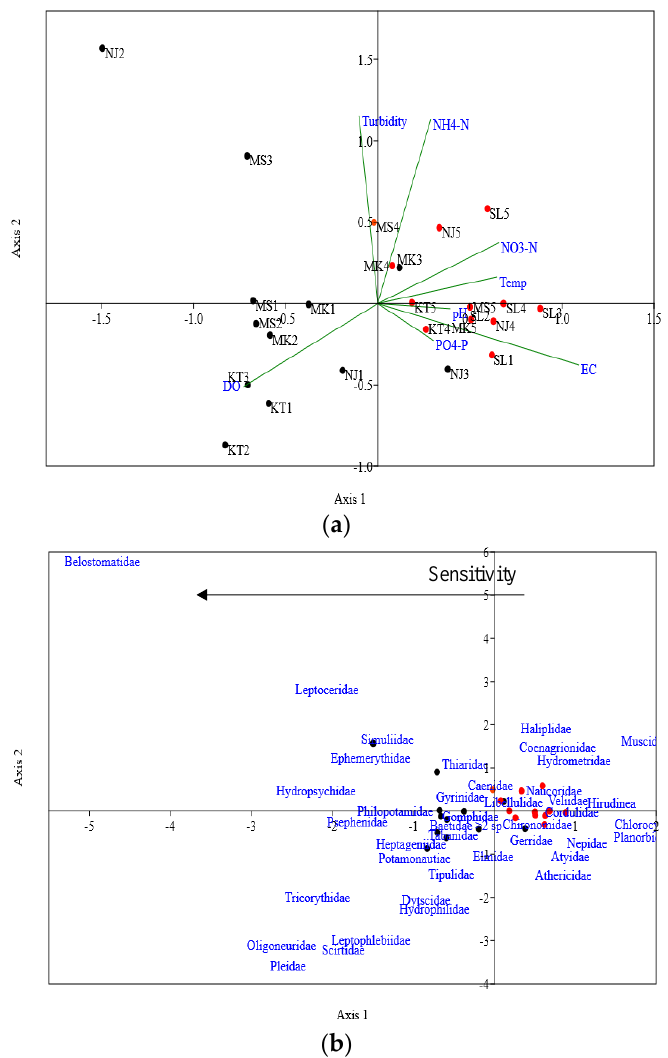
Figure 6. Canonical correspondence analysis biplot of physical-chemical water quality parameters ( a ) and scatter plot of macroinvertebrate taxa ( b ) at different sampling sites of the different streams in Kilombero Valley. The red dots indicate downstream sampling sites and sampling site 1, 2 and 3 of Sululu stream. Black dot indicates upstream sampling sites and green arrow physical-chemical parameters of water.